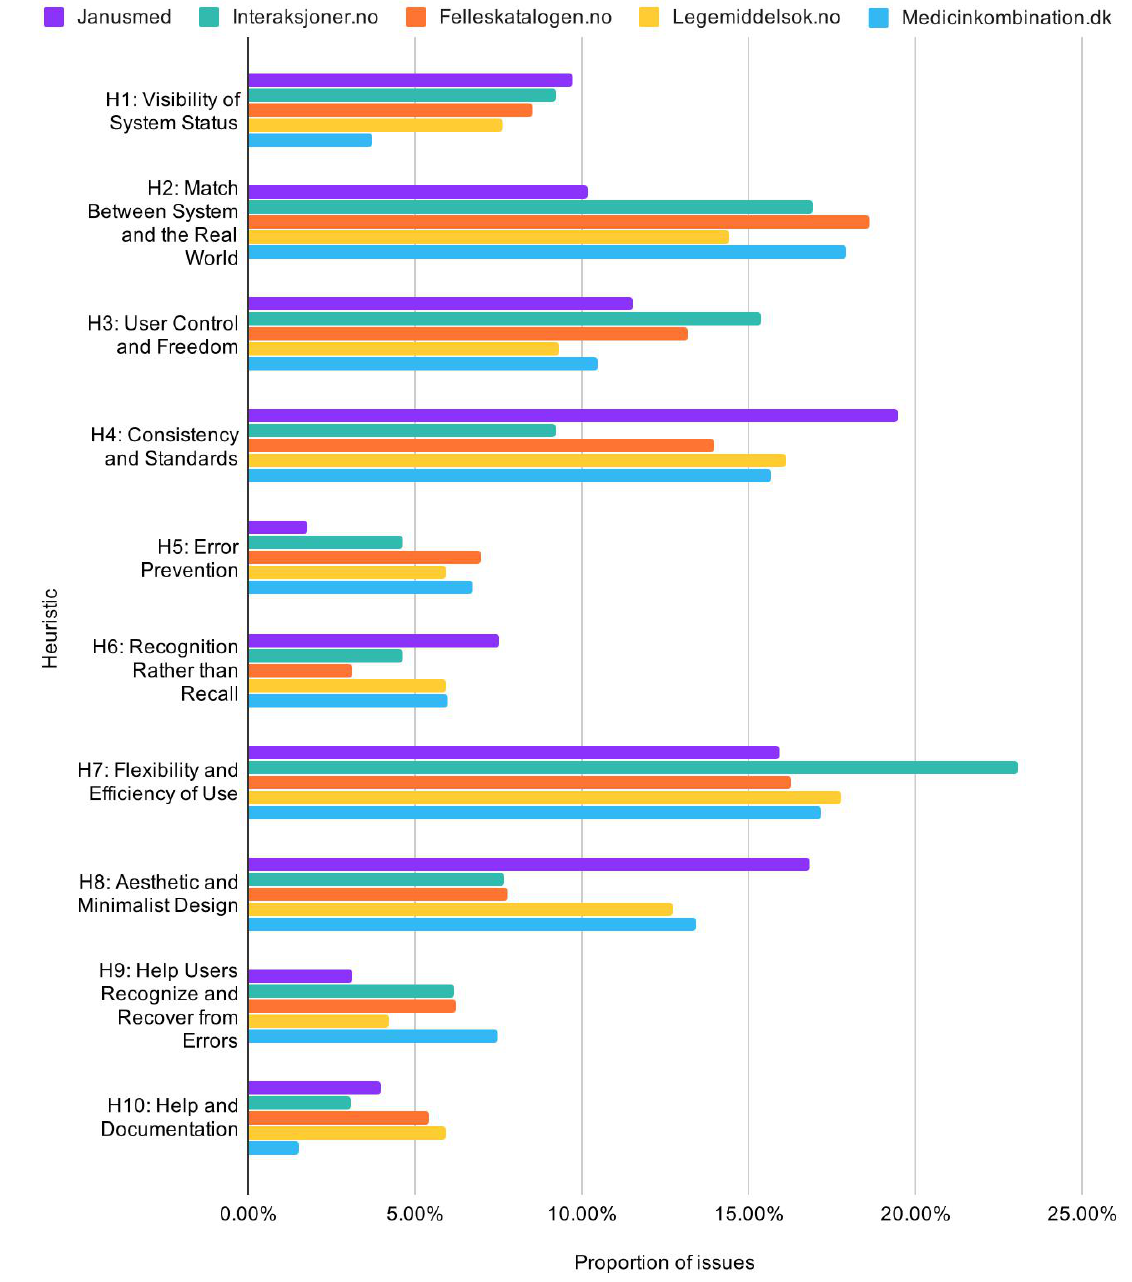
Figure 10. Proportion of usability issues by heuristic across services.